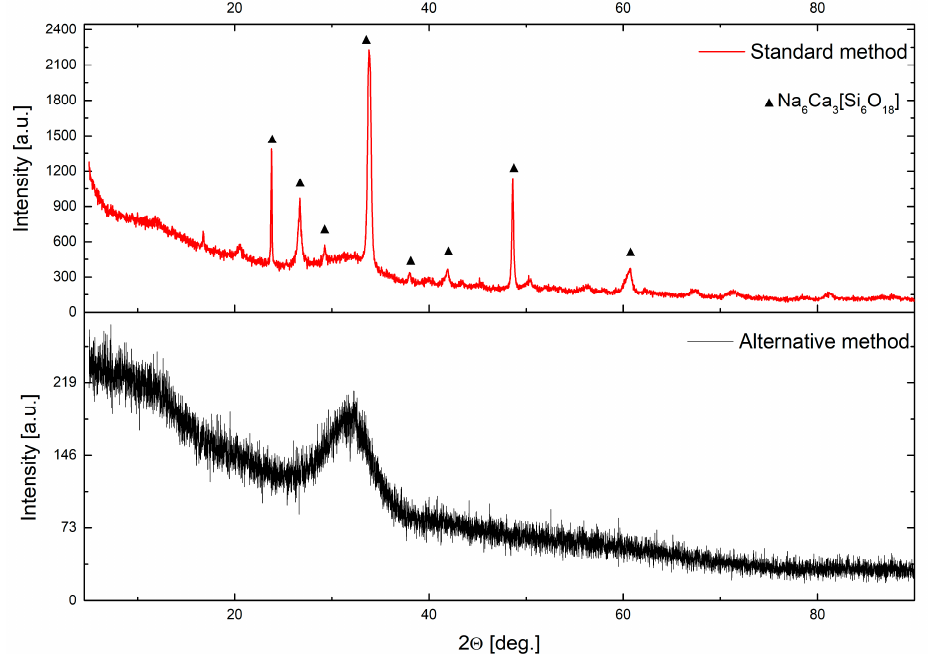
Figure 14. XRD patterns of fabricated 45S5 glass fiber drawn by a standard and alternative method.